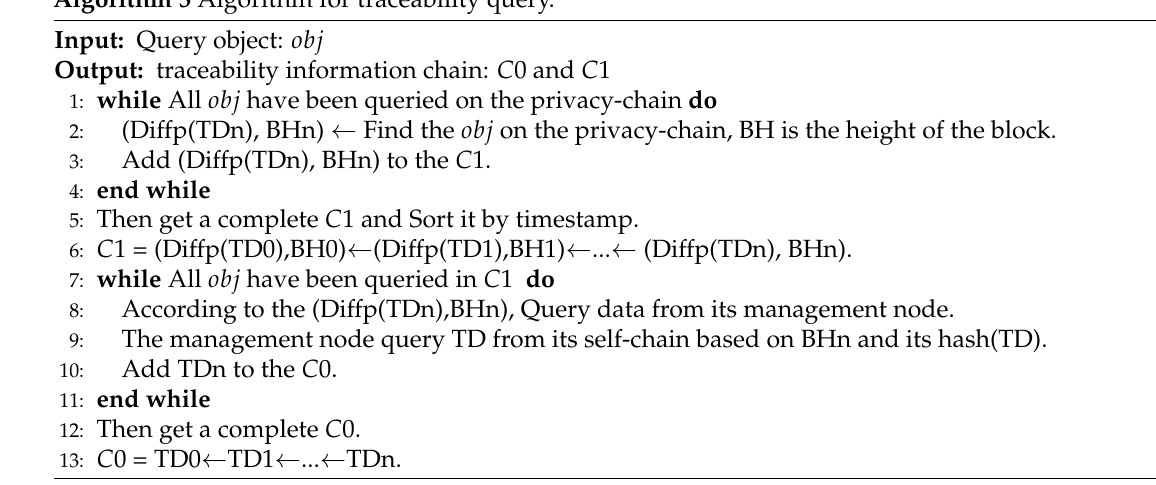
Algorithm 5 Algorithm for traceability